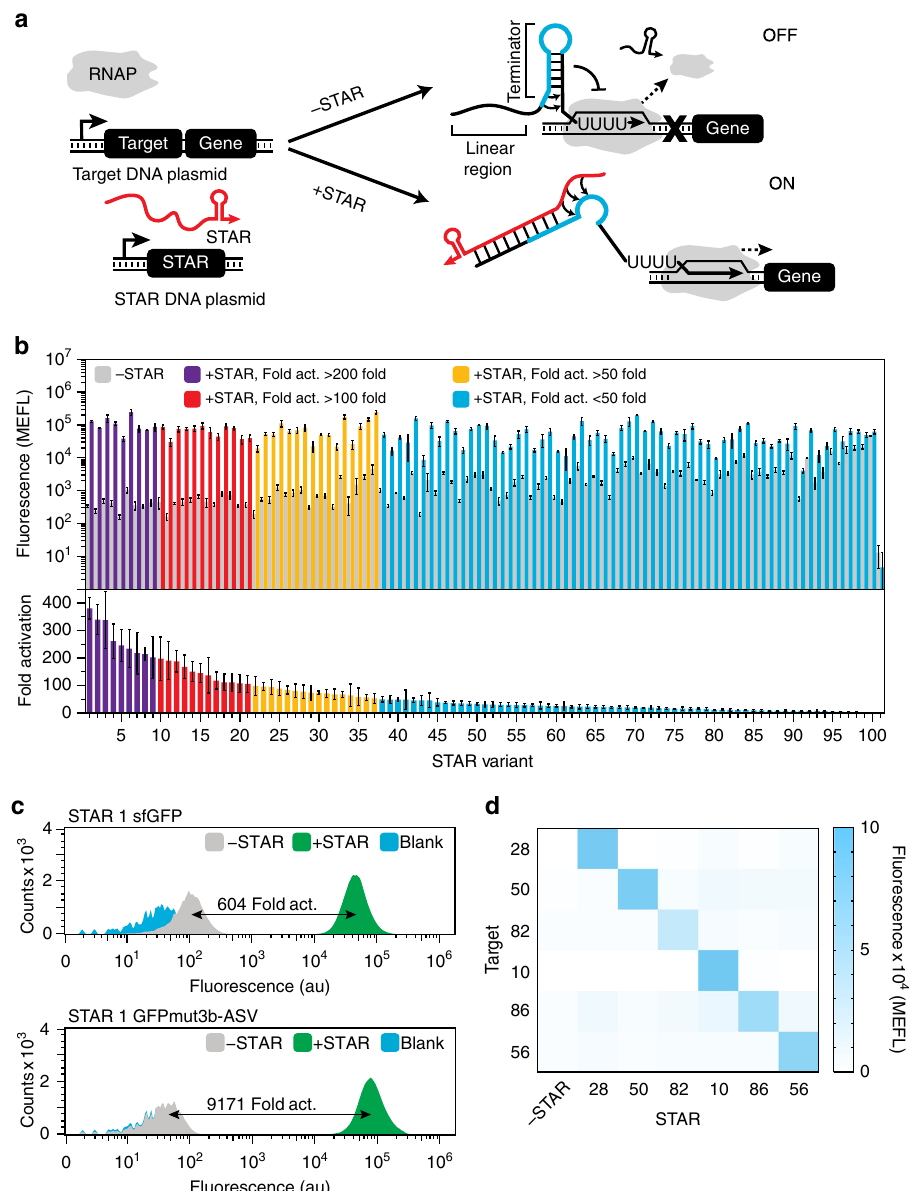
Fig. 1 Characterization of a computationally designed STAR library. a Schematic of the Small Transcription Activating RNA (STAR) mechanism. A target DNA sequence is placed upstream of a gene, which is designed to fold into an intrinsic terminator hairpin, composed of a hairpin structure followed by a poly-uracil sequence. The formation of this terminator hairpin causes RNA polymerase (RNAP) to terminate transcription upstream of the gene (gene OFF). STARs (colored red ) bind to both the linear region and the 5 ’ half of the terminator hairpin (colored blue ) of the target RNA, preventing terminator formation and allowing transcription elongation of the gene (gene ON). b Characterization of 100 computationally designed STAR:target variants and the original AD1 STAR (variant 28) 30 . Fluorescence characterization was performed on E. coli cells transformed with a plasmid encoding each target RNA variant controlling superfolder GFP (sfGFP) expression in the absence (-STAR) and presence (+STAR) of a plasmid encoding its cognate STAR. Upper panel shows mean fl uorescence and lower panel shows fold activation (ON/OFF), colored accordingly to the fold activation. A Welch ’ s t -test showed all variants had a statistically signi fi cant difference between -STAR and +STAR conditions ( P < 0.05). c Flow cytometry histograms of a target RNA expressing sfGFP and GFPmut3b-ASV in the absence ( − STAR) and presence (+STAR) of cognate STAR, compared to the auto fl uorescence of E. coli cells transformed with control plasmids (Blank). d Characterization of 6 STAR:target pairs predicted to be orthogonal (Supplementary Fig. 10) by challenging target RNAs controlling sfGFP expression against cognate and non-cognate STARs. Fluorescence characterization was performed as in b for each STAR:target combination. Cognate pairs are across the diagonal and the -STAR condition in the left column. Raw data shown in Supplementary Fig. 11. Data were measured with fl ow cytometry in units of arbitrary fl uorescence (au, panel c ) or Molecules of Equivalent Fluorescein (MEFL, panel b , d ). Data in b , d represent mean values and error bars represent s.d. of at least n = 7 biological replicates, and c a representative fl ow cytometry histogram of n = 1 biological replicates with repeats shown in Supplementary Fig.